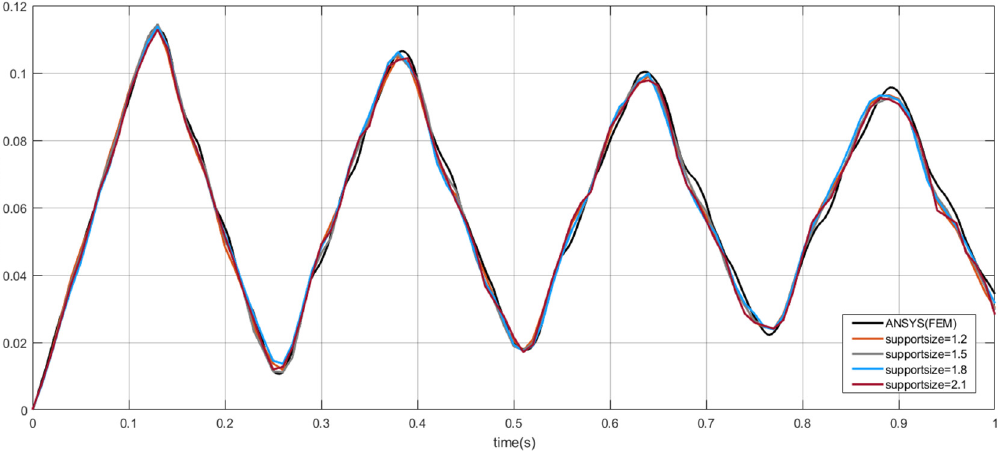
Figure 10. Influence of the support size in a cantilever beam under an end load (105 nodes with nodal distance d = 1.0 m, at point